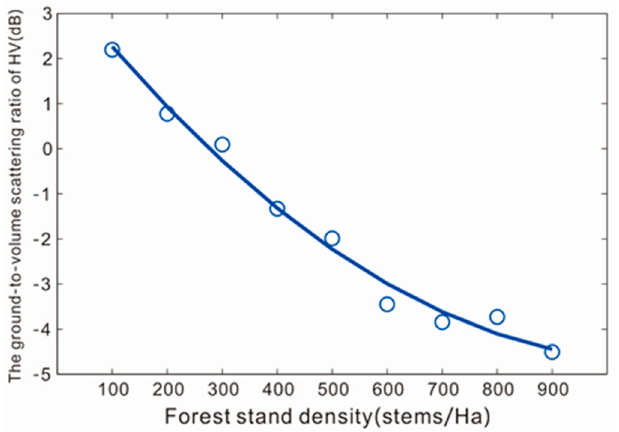
Figure 3. Correlation between the ground-to-volume scattering ratio and density from the simulated data with reference height of 10 m.